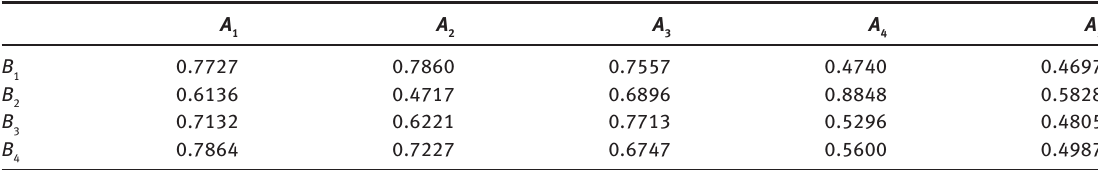
Table 3: Correlation Coefficients of Symptoms for Each